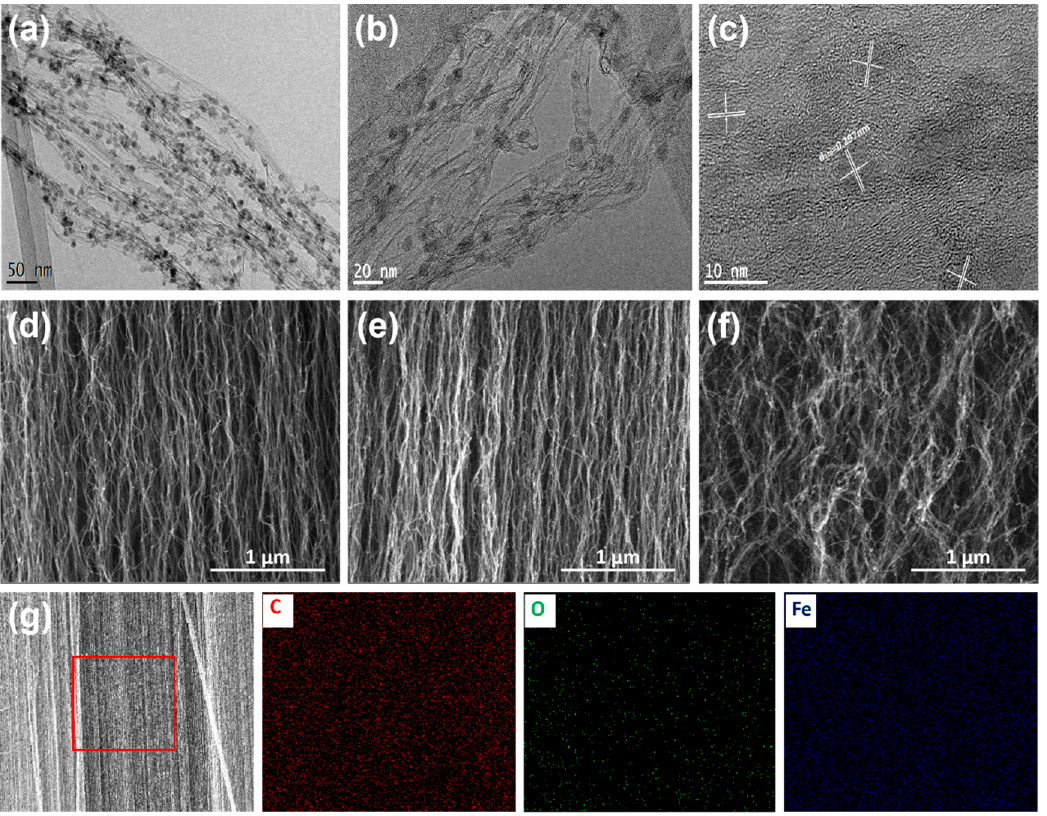
Figure 2. TEM ( a , b ) and HRTEM ( c ) images of the Fe 3 O 4 /VACNTs-550 composites. ( d – f ) Cross-sectional FESEM images of Fe 3 O 4 /VACNTs composites at different annealing temperature (500, 550 and 600 °C, respectively). ( g ) Cross-sectional SEM image of the VACNTs-550 and corresponding EDS elemental mapping.